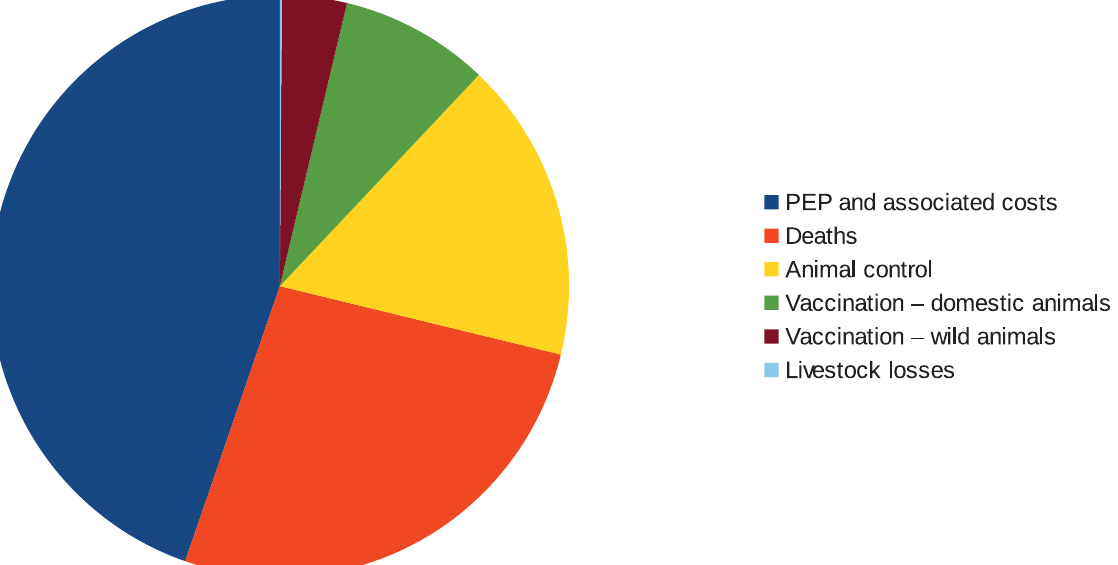
Fig 6. The relative contribution of different cost items to the total economic losses caused by rabies in Kazakhstan.